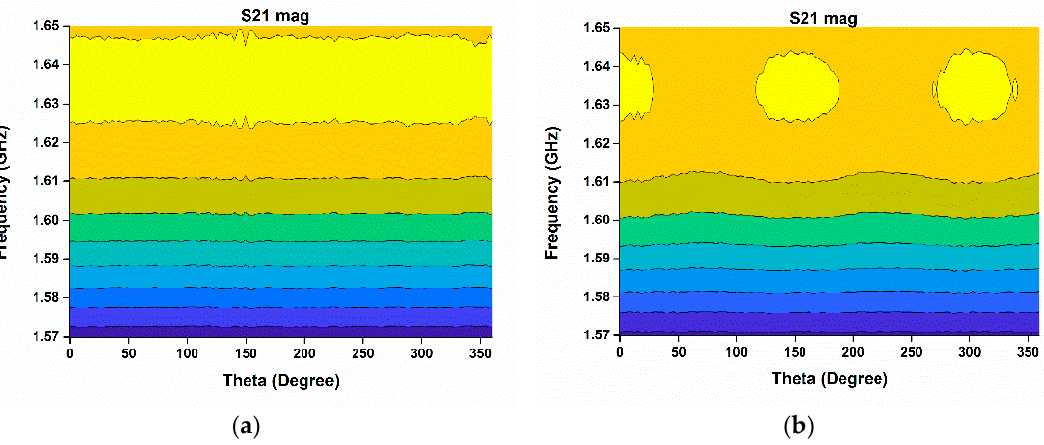
Figure 14. Microwave imaging result using the proposed sensor antenna; ( a ) without tumor; ( b ) with tumor.